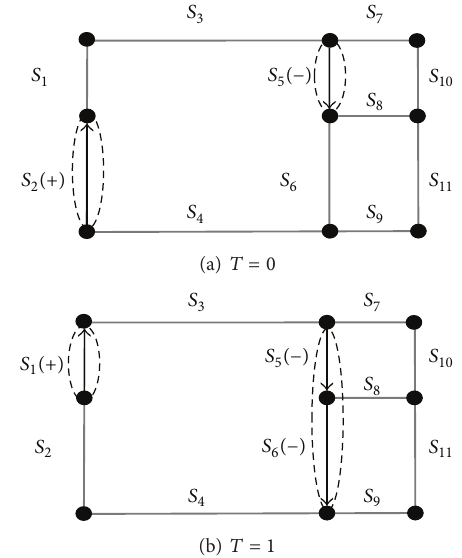
Figure 4: The clusters according to different